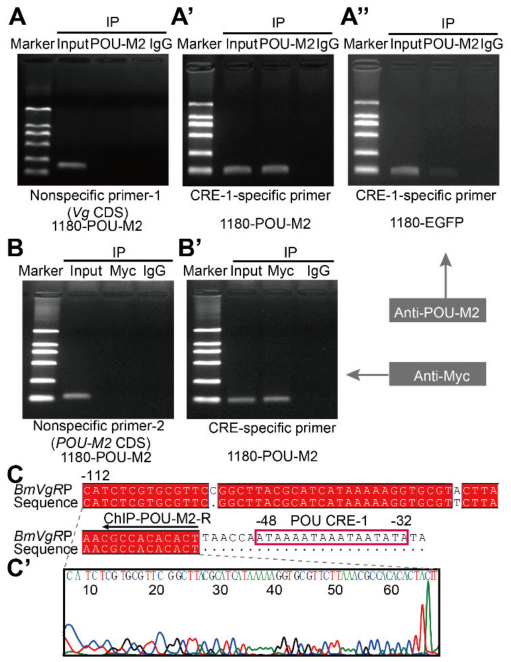
Figure 4. ChIP assays to evaluate the binding of POU-M2 to overlapping CREs in the BmVgR promoter. ( A ) and ( B ): PCR results (nonspecific primers) from the ChIP assays in BmNs cells overexpressing Myc-tagged POU-M2. ( A’ ), ( A” ), and ( B’ ): PCR results (POU CRE-specific primers) from the ChIP assays in BmNs cells overexpressing Myc-tagged POU-M2 and EGFP. ( C ) and ( C’ ): Sequences of the specific PCR band from the ChIP assays.